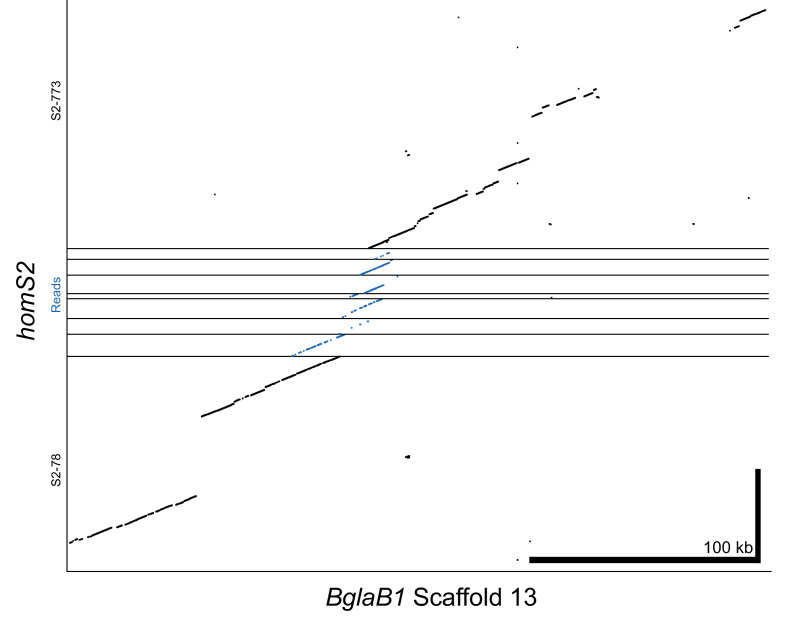
Alignment of homS2 contigs and raw PacBio reads to reference genome BglaB1 contig 13.Raw reads span the 12.6 kb gap between contigs, which is further confirmed by the high similarity between homS2 and BglaB1. Thus, S2-78 and S2-773 have been combined into a single haplotype throughout our analysis (e.g. Figure 2).